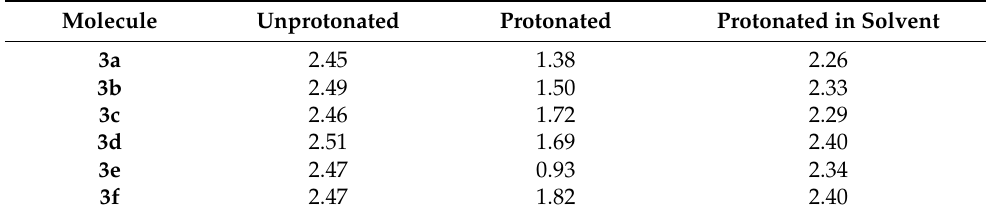
Table 9. Chemical hardness ( η ), in eV, of unprotonated molecules, protonated forms, and in liq- uid phase.